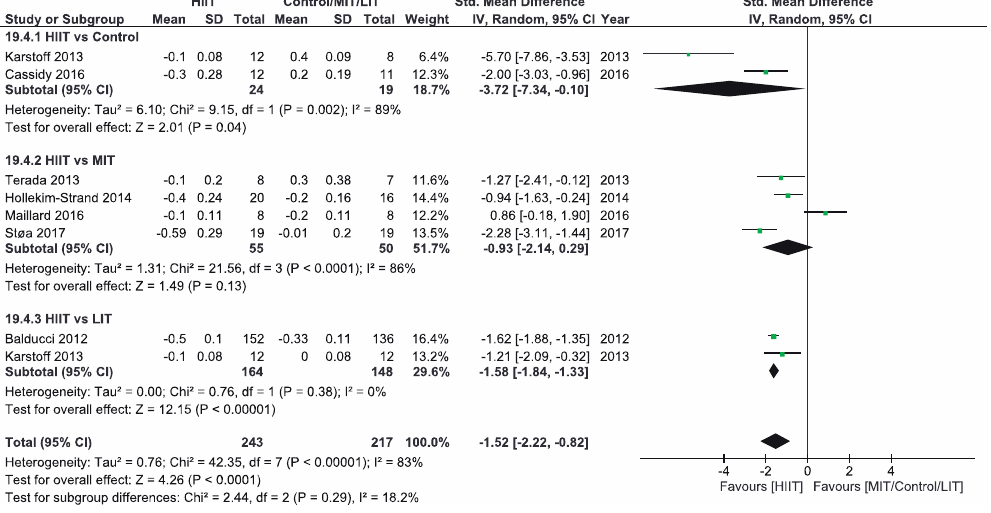
Figure 7. Forest plot for HbA 1c . HIIT—high-intensity interval training, MIT—moderate-intensity training, LIT—low-intensity training, CI—confidence interval, IV—inverse variance, SD—standard deviation.